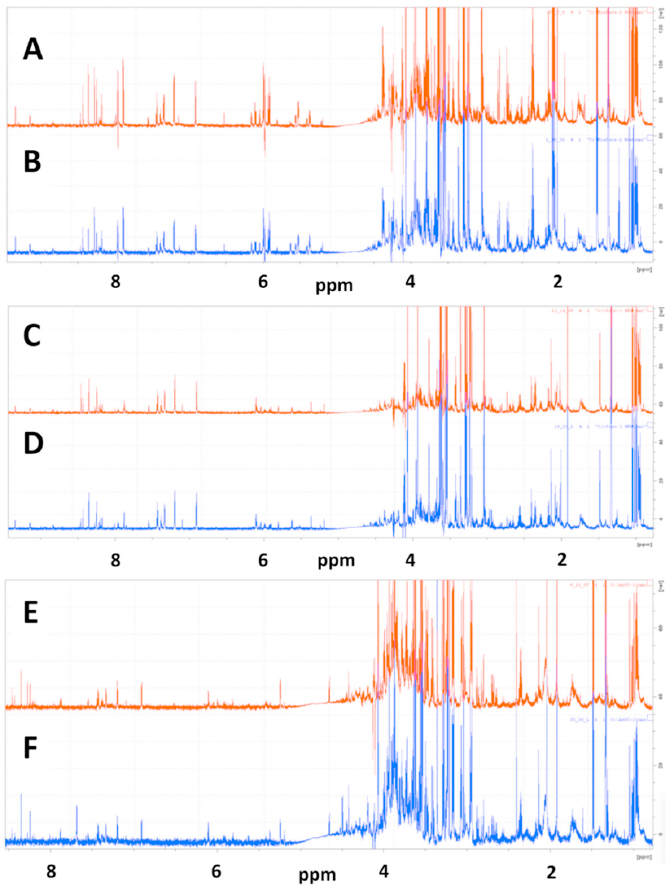
Figure 1. Representative 1D 1 H NMR spectra of SpeedVac dried and lyophilized MiaPaCa-2, Panc-1 and AsPC-1 cell extracts. 1D CPMG NMR spectra are shown for representative SpeedVac-dried cell extracts for ( A ) MiaPaCa-2, ( C ) Panc-1 and ( E ) AsPC-1 cells and for representative lyophilized cell extracts for ( B ) MiaPaCa-2, ( D ) Panc-1 and ( F ) AsPC-1 cells.